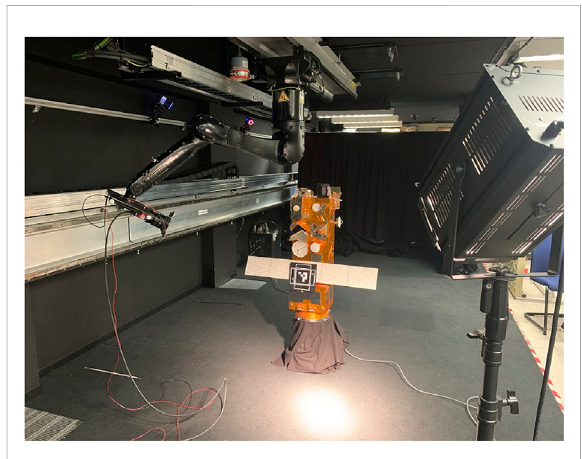
FIGURE 9 LED mount as applied to the